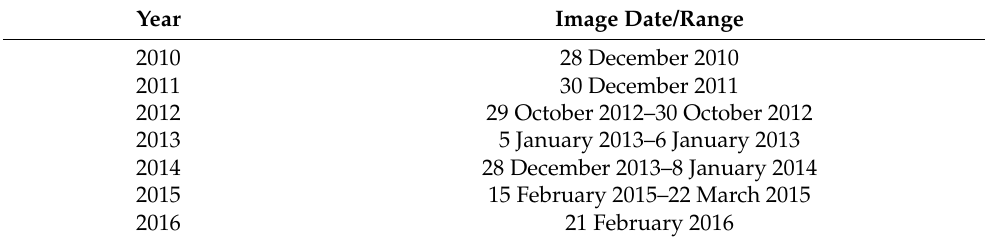
Table 1. Summary of aerial imagery acquired [49] and used in this study.